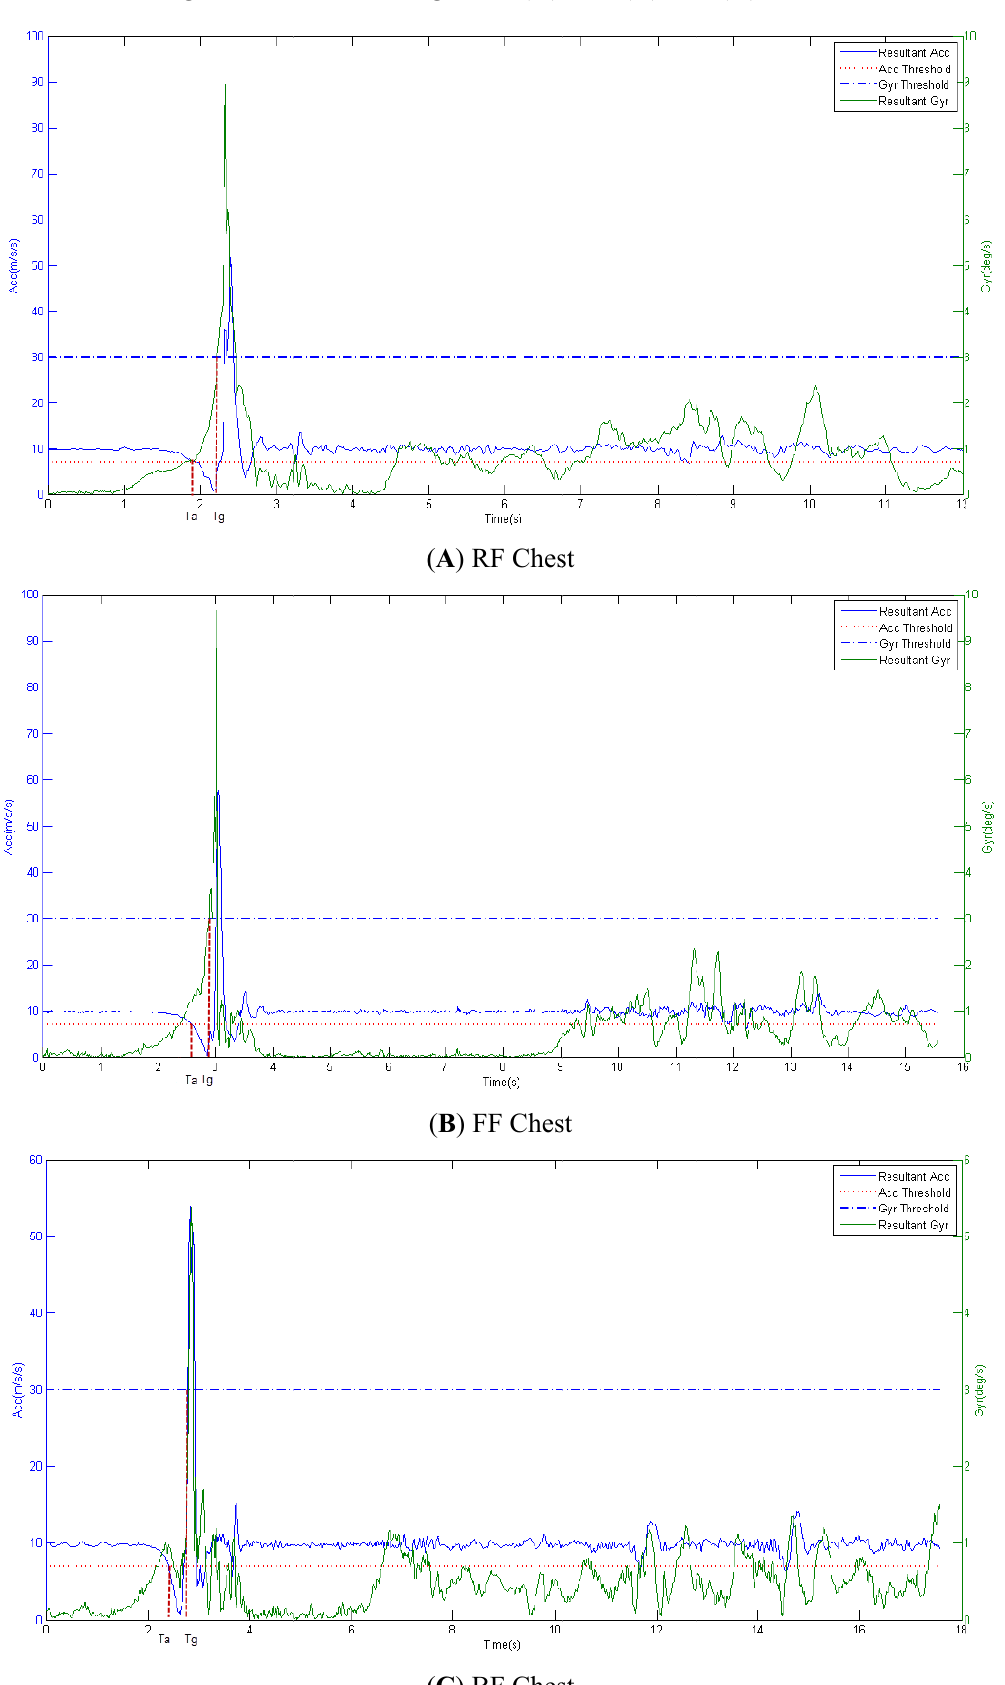
2 , 12 Figure e 6. Determ amination of ratef optimal pr re-impact l using the accele ration and angular